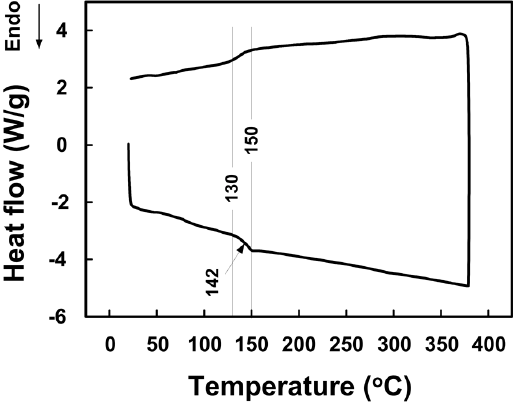
Figure 3. Typical differential scanning calorimetric (DSC) result (the second cycle).